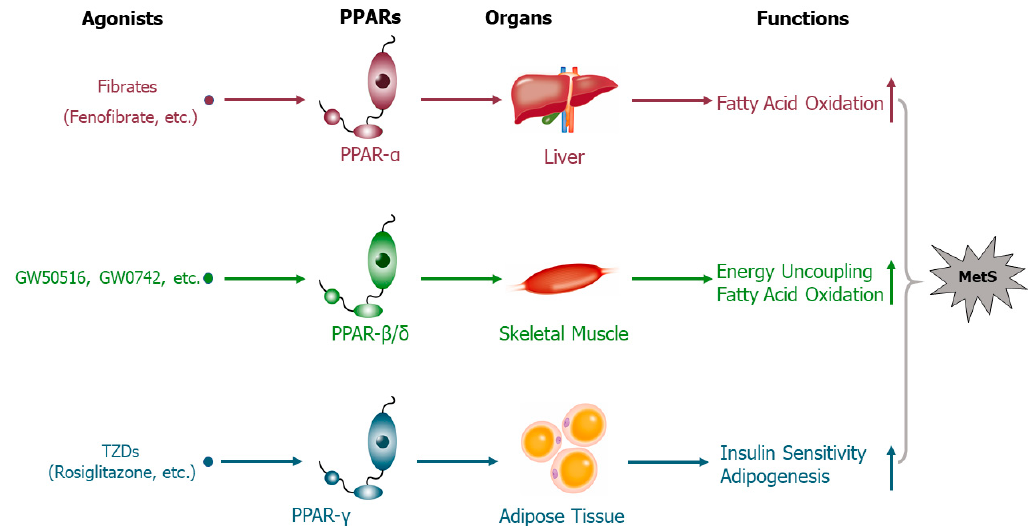
Figure 2. Major roles of peroxisome proliferator-activated receptor (PPAR) isotypes in metabolic syndrome (MetS). PPARs are a class of nuclear transcriptional factors activated by physiological stimuli (fatty acids and eicosanoids) and synthetic small molecules (fibrates for PPAR- α ; GW501516, GW0742, bezafibrate, and telmisartan for PPAR- β / δ ; thiazolidinediones (TZDs) for PPAR- γ ). PPAR- α is mainly expressed in liver tissue, where it controls a set of genes facilitating fatty acid oxidation, thereby lowering circulating triglyceride levels. PPAR- β / δ modulates a series of genes involved in energy uncoupling and fatty acid oxidation in skeletal muscle, resulting in increased energy expenditure and reduced plasma triglyceride levels. PPAR- γ is abundantly expressed during increasing adipogenesis in adipose tissues, where it governs multiple genes and thereby improves insulin sensitivity and decreases lipolysis. All the members of the PPAR family can be activated by relevant agonists. Although di ff erent PPARs have unique non-overlapping patterns of biological functions, all three isoforms act on given tissues and share similar biological